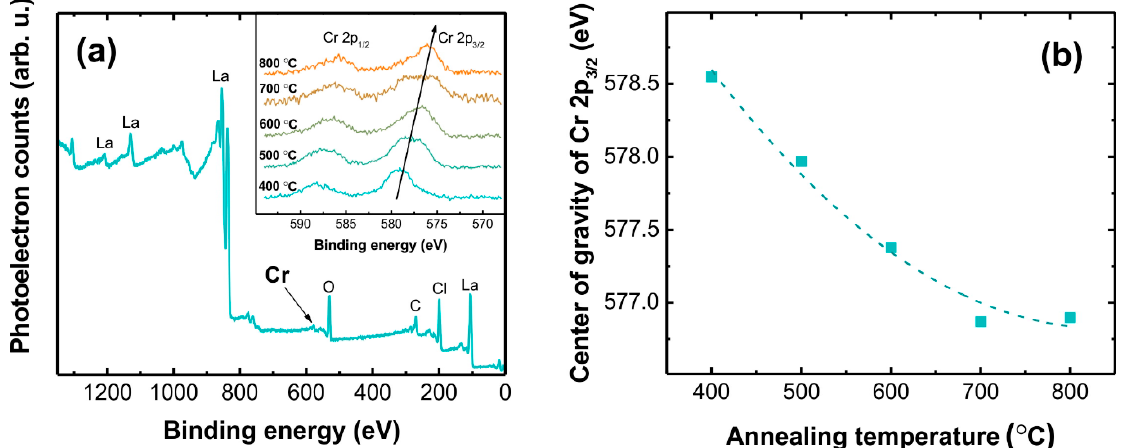
Figure 6. ( a ) XPS spectrum of the 5% Cr LaOCl sample prior annealing in a reducing atmosphere; inset: background corrected XPS spectra in Cr 2p peak range of 5% Cr LaOCl samples annealed at different temperatures in H 2 /Ar atmosphere and ( b ) binding energy of Cr 2p 3/2 to the annealing temperature of the samples.